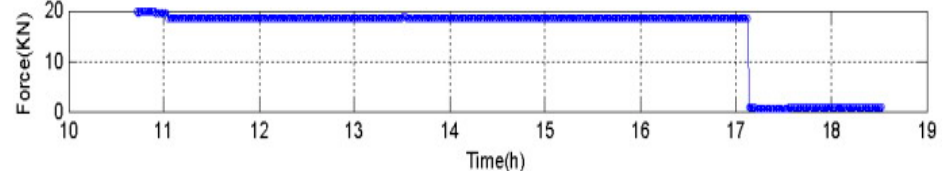
Figure 8. The pretightening force of the bolt when the initial pretightening force is 15% of the yield strength and excitation frequency is 6 Hz.